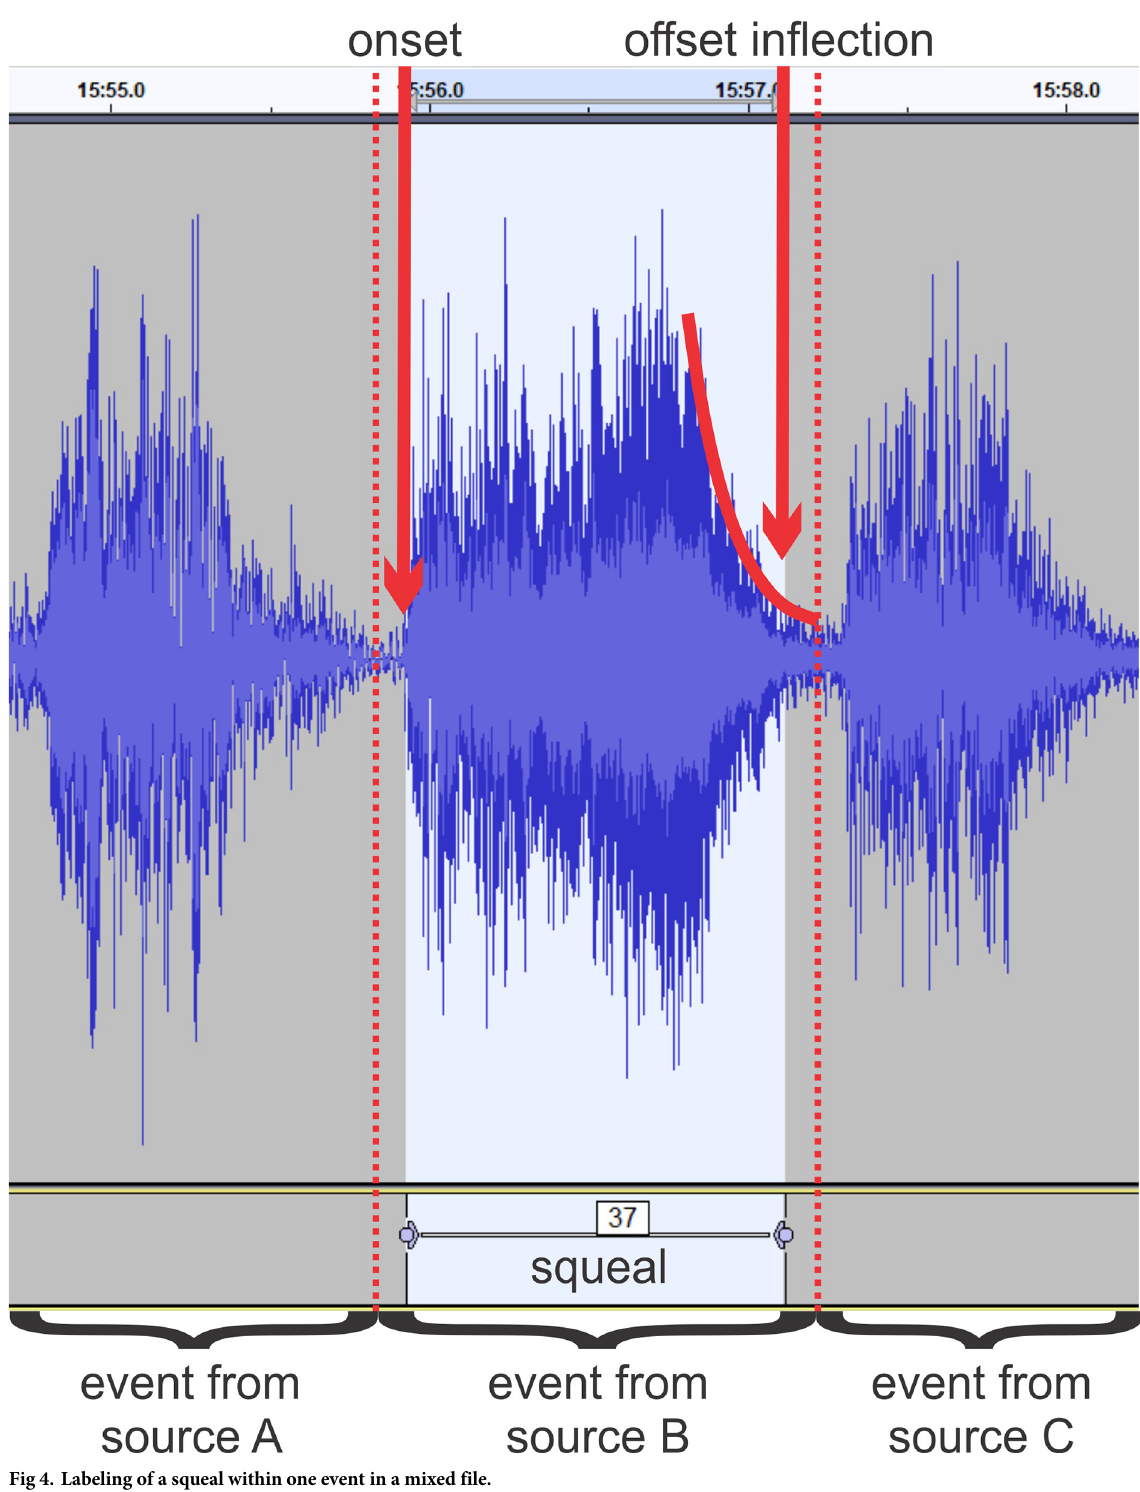
Fig 4. Labeling of a squeal within one event in a mixed file.